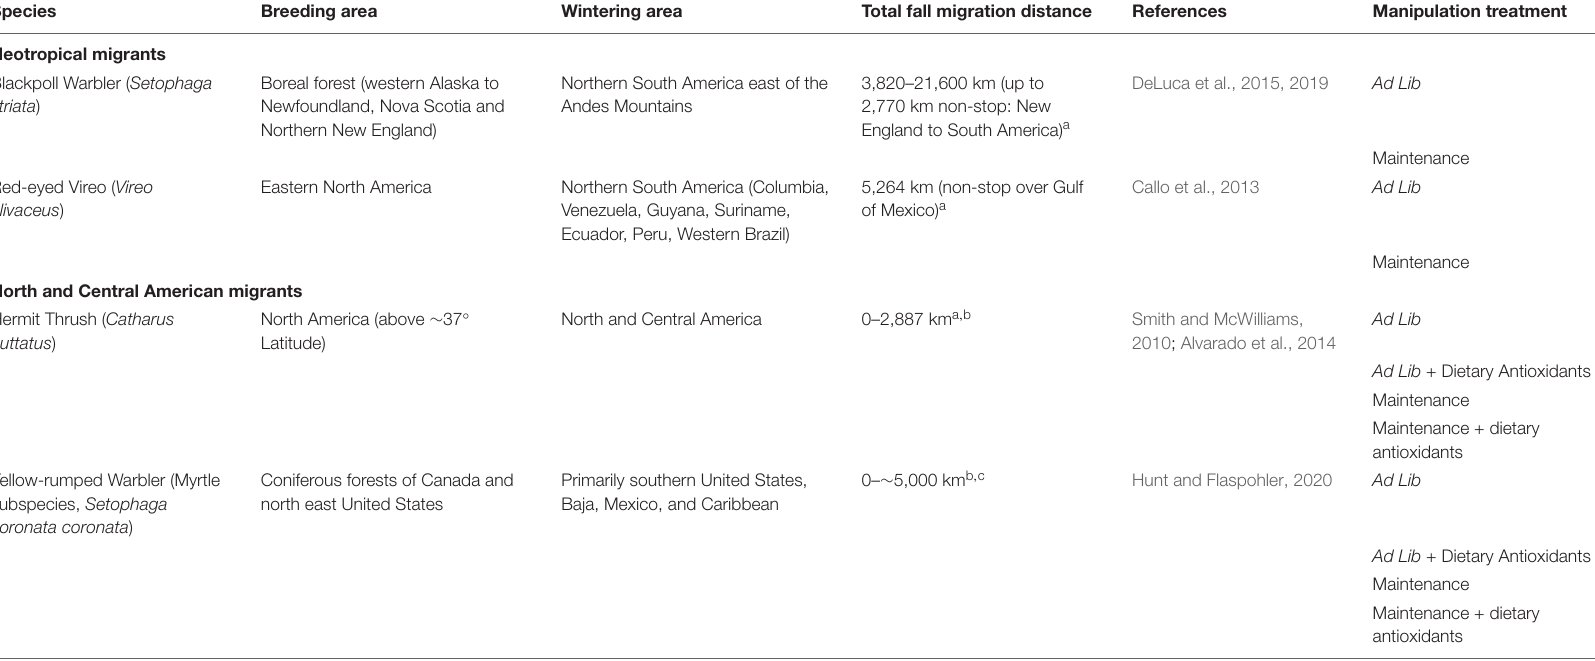
TABLE 1 | Total migration distances and experimental treatment groups for Blackpoll Warblers, Red-eyed Vireos, Hermit Thrushes, and Yellow-rumped Warblers.